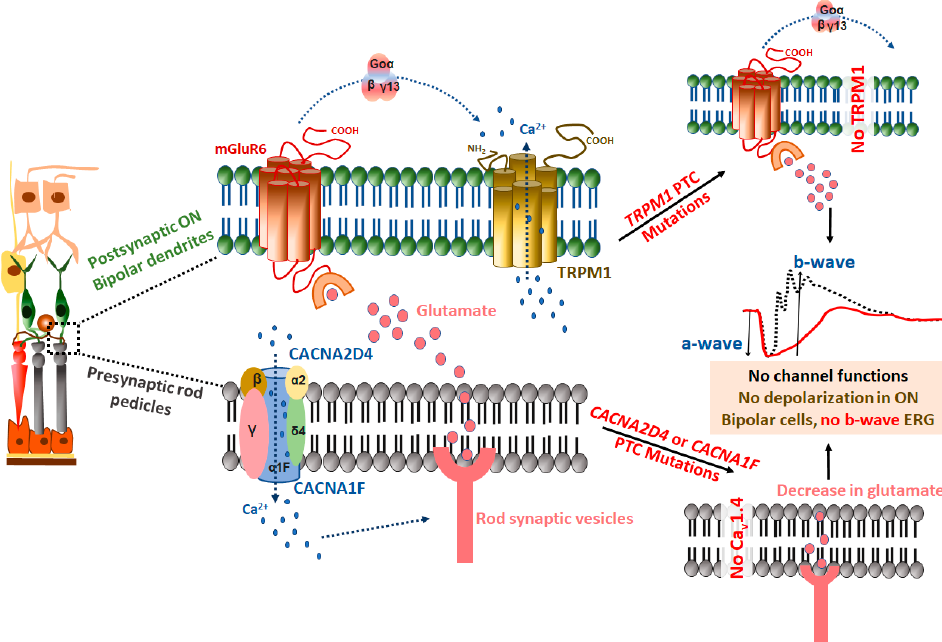
Figure 5. Nonsense mutations in ion channel genes underlying Congenital Stationary Night Blindness (CSNB). The electroretinogram (ERG) trace represents control (black trace) and no b-wave (red trace), a and b-wave are marked by downward and upward arrows, respectively.